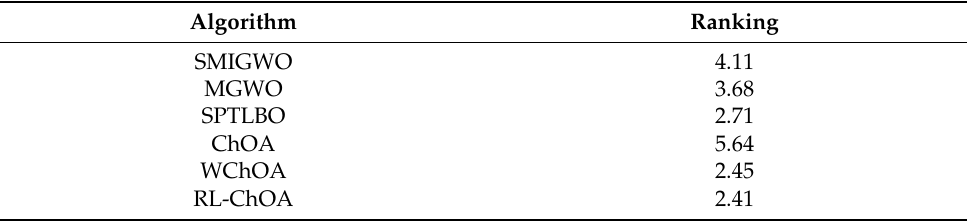
Table 6. Average rankings of the algorithms (Friedman) on unimodal benchmark test functions.